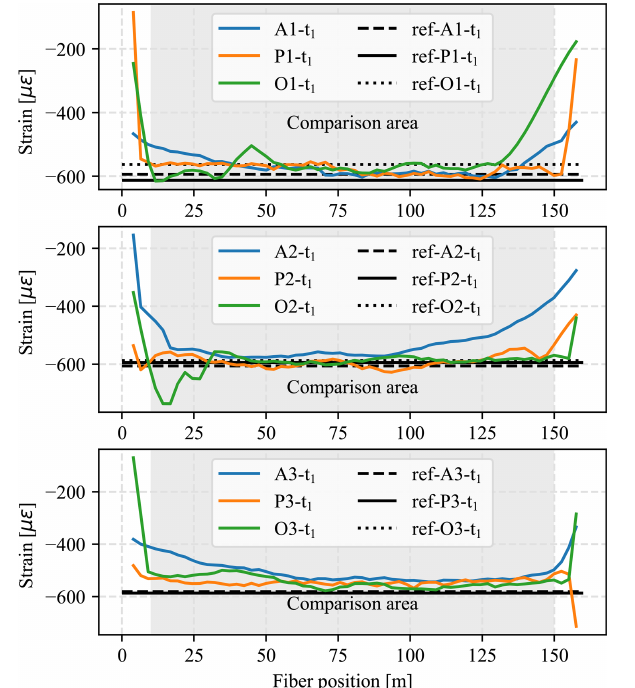
Figure 7. Strain profiles of all specimens at test time t 1